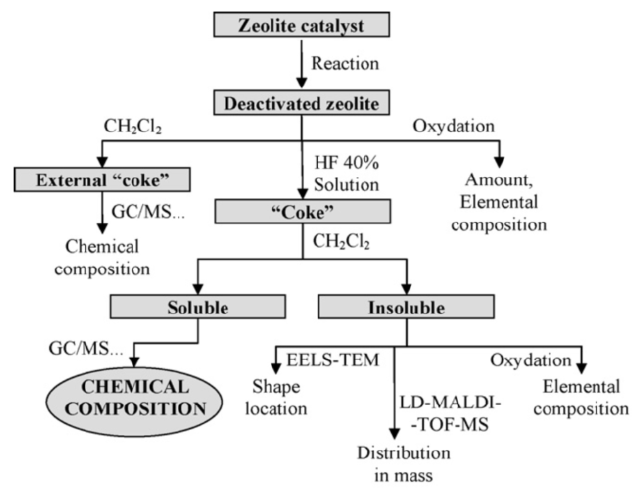
Figure 21. Method for the determination of zeolite coke nature and composition developed by Guis- Guisnet et al. Graphical abstract from Gusinet et al. net et al. Graphical abstract from Gusinet et al. [75].